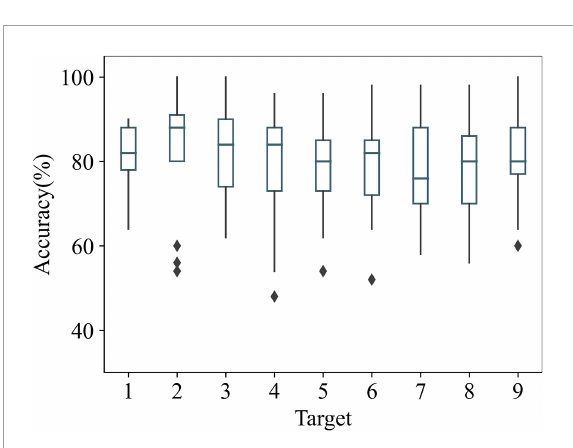
FIGURE12 Recognition accuracies of AR–P300 for all participants with different targets.